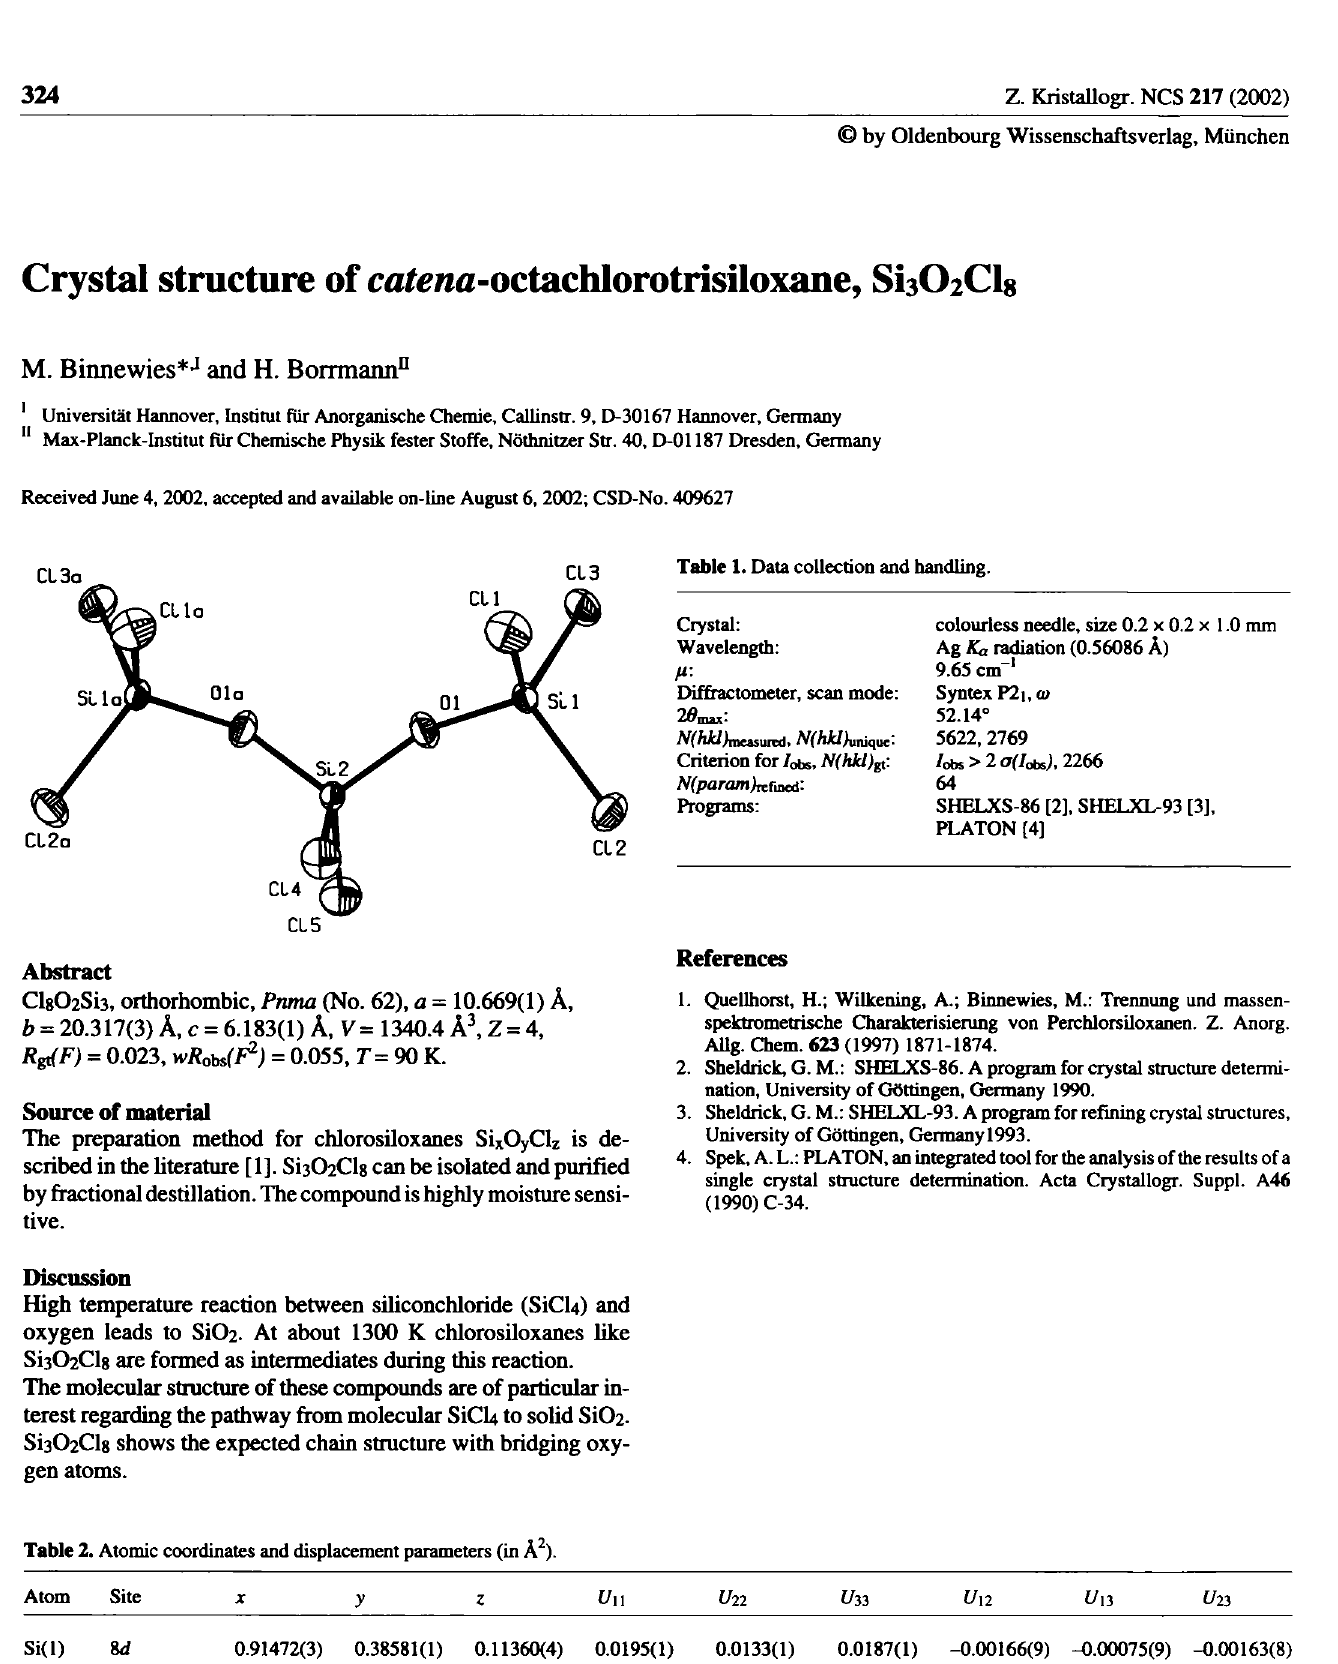
Table 2. Atomic coordinates and displacement parameters (in Â 2